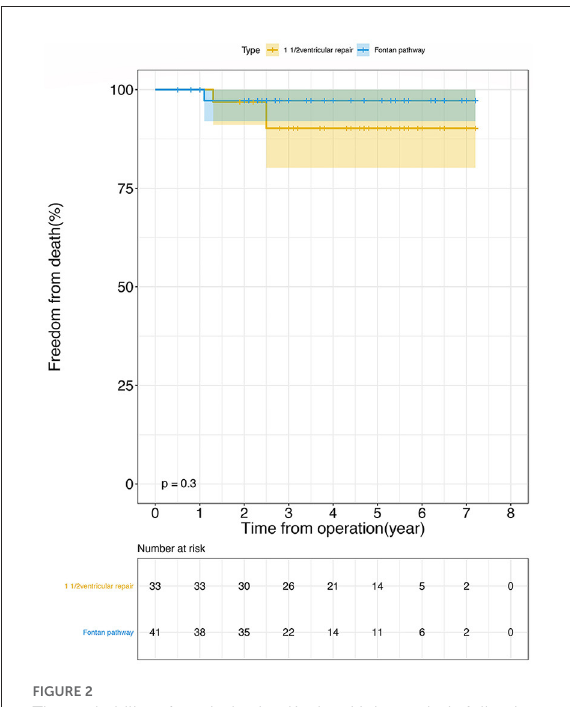
FIGURE3 Freedom from reoperation and transcatheter intervention after operation using Kaplan-Meier analysis: 1 1/2 ventricular repair (orange line), Fontan pathway (blue line). There was no statistical difference between the two groups (Log-rank p = 0.110). The confidence limits were indicated as a colored shaded area and the numbers at risk were shown below the figure.